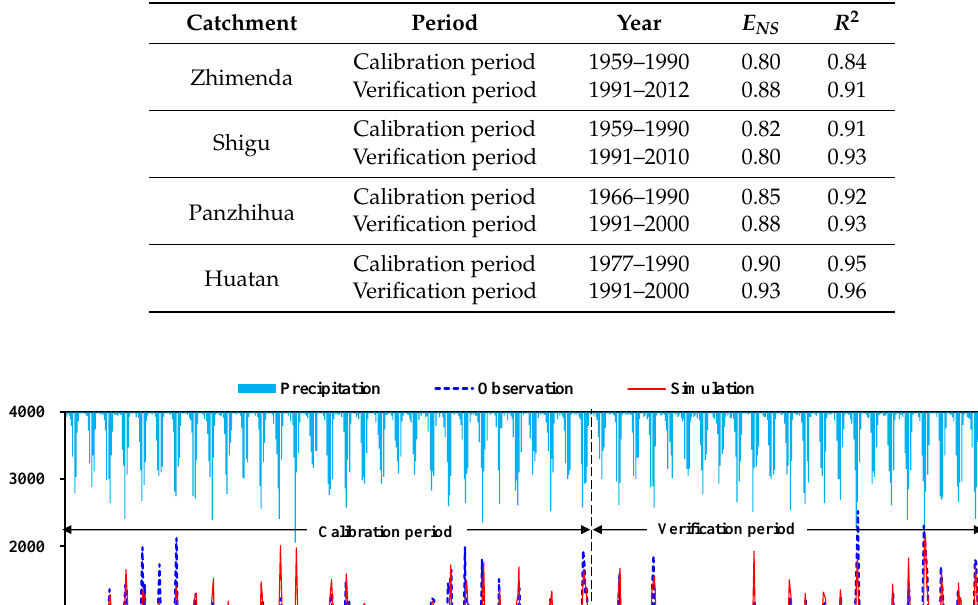
Table 3. Performance of the SWAT for monthly streamflow simulation in the Zhimenda, Shigu, Panzhihua and Huatan catchment.